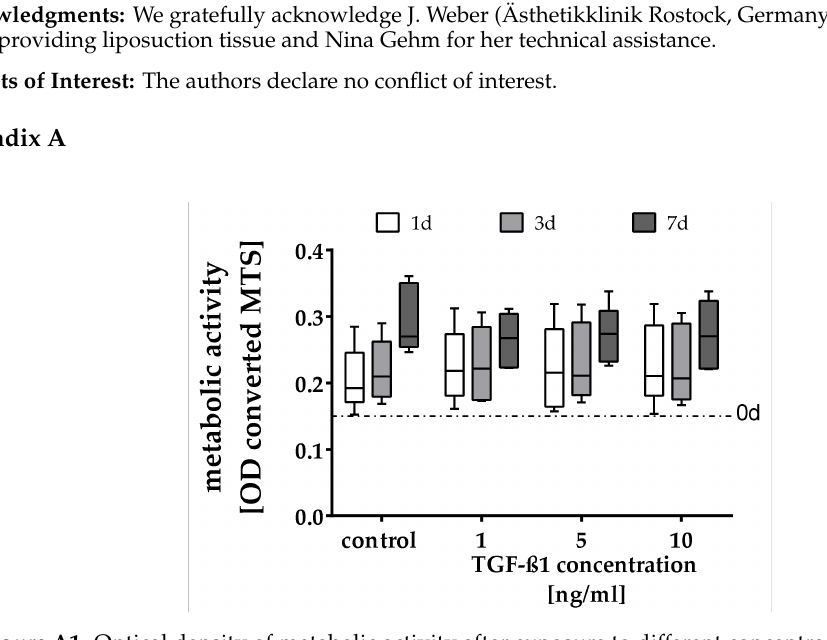
Figure A1. Optical density of metabolic activity after exposure to di ff erent concentrations of TGF-ß1 on day 0, 1, 3, and 7 (metabolic activity measured via MTS conversion assay). Data presented as box plots with medians, interquartile ranges, and minimum / maximum values ( n = 6). Since the dataset did not represent a Gaussian distribution (Shapiro-Wilk test), the statistical analysis was performed using the Two-Way ANOVA test followed by Dunnett’s multiple comparison post hoc test. * p ≤ 0.05. Comparison with the